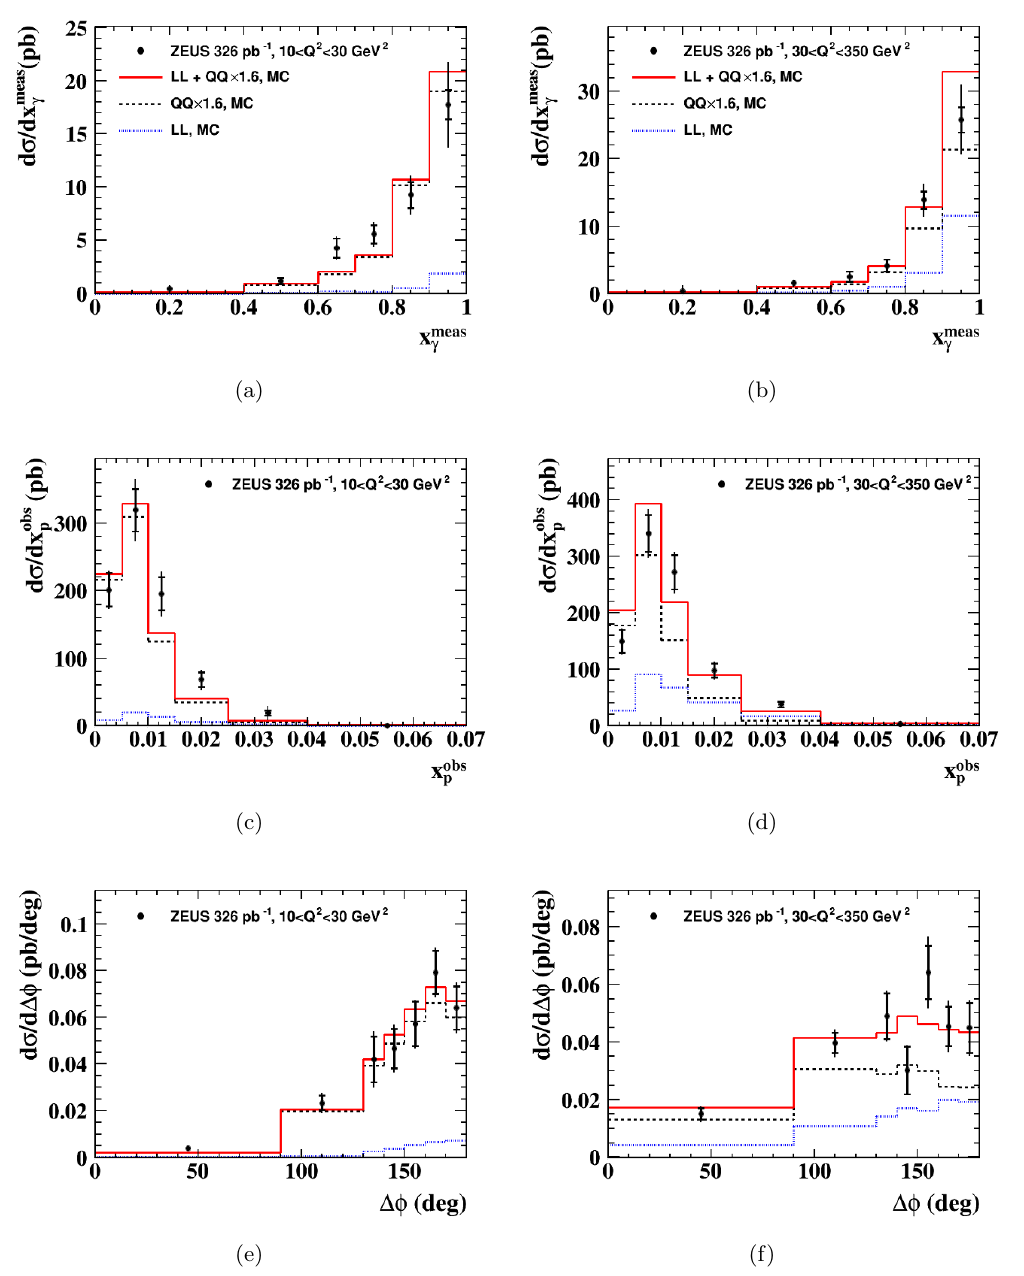
Figure 4 . Di(cid:11)erential cross sections for the regions 10 < Q 2 < 30 and 30 < Q 2 < 350 GeV 2 : (a, b) x meas , (c, d) x obs , and (e, f) (cid:1) (cid:30) . The inner and outer error bars show, respectively, (cid:13) p the statistical uncertainty and the statistical and systematic uncertainties added in quadrature. The solid histograms are the Monte Carlo predictions from the sum of QQ photons from Pythia normalised by a factor 1.6 plus Djangoh-Heracles LL photons. The dashed (dotted) lines show the QQ (LL) contributions.